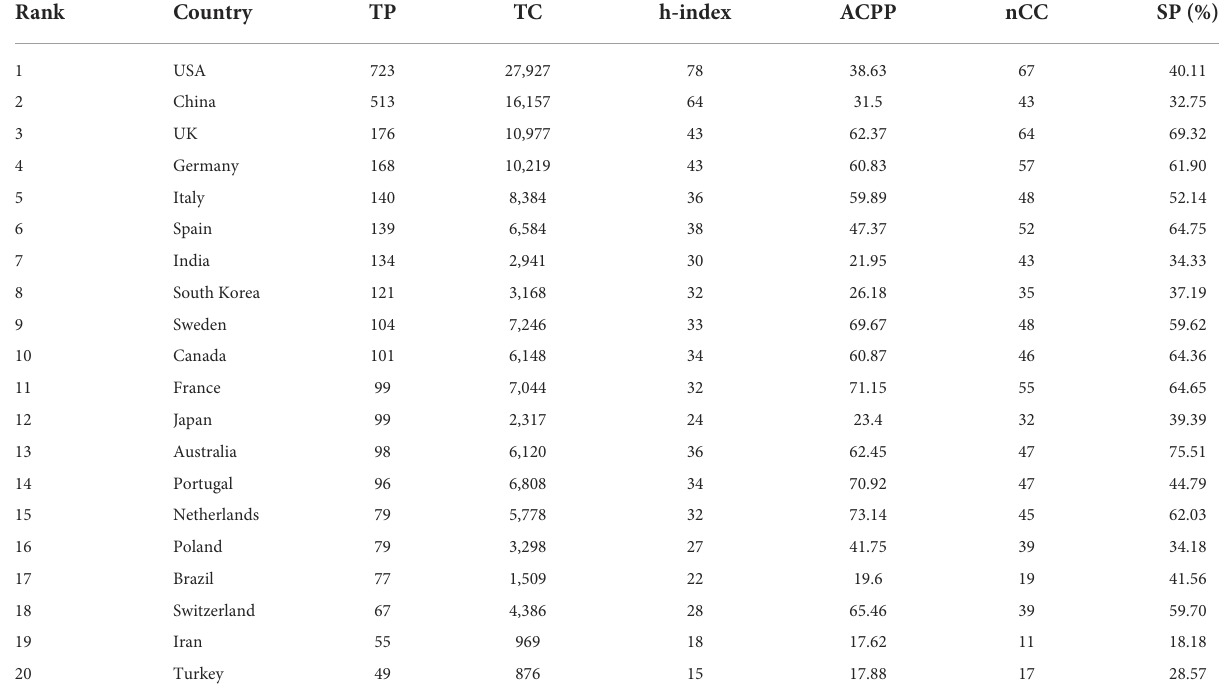
TABLE 1 The top 20 most productive countries/regions in the ARB field.